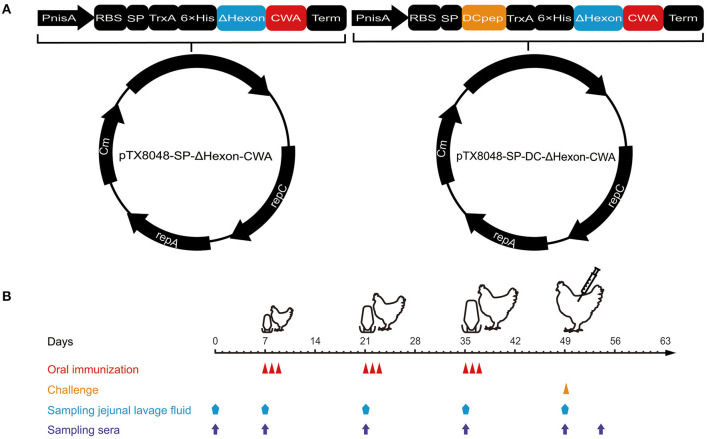
Procedures of immunization, viral challenge, and sampling. (A) Schematic diagram of the recombinant plasmids pTX8048-SP-ΔHexon-CWA and pTX8048-SP-DC-ΔHexon-CWA. (B) The immunization procedures and sampling schedules. Chickens were immunized with the constructed ΔHexon-expressing bacteria three times at 2-week intervals and experimentally challenged with hypervirulent FAdV-4/GX01 strain on day 14 post the third immunization.